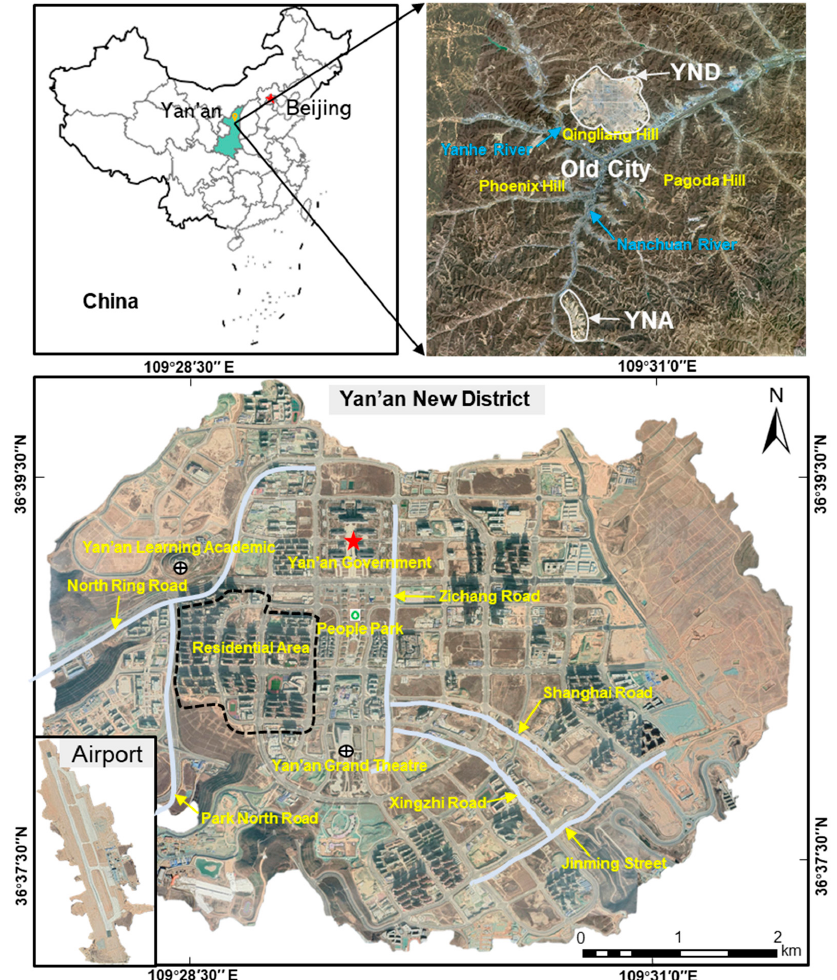
Figure 1. The Yan’an urban area and the basic information of the research area, superimposed on the Google Earth image obtained 25 March